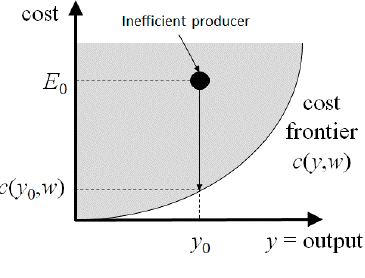
Figure 5. Cost frontier.